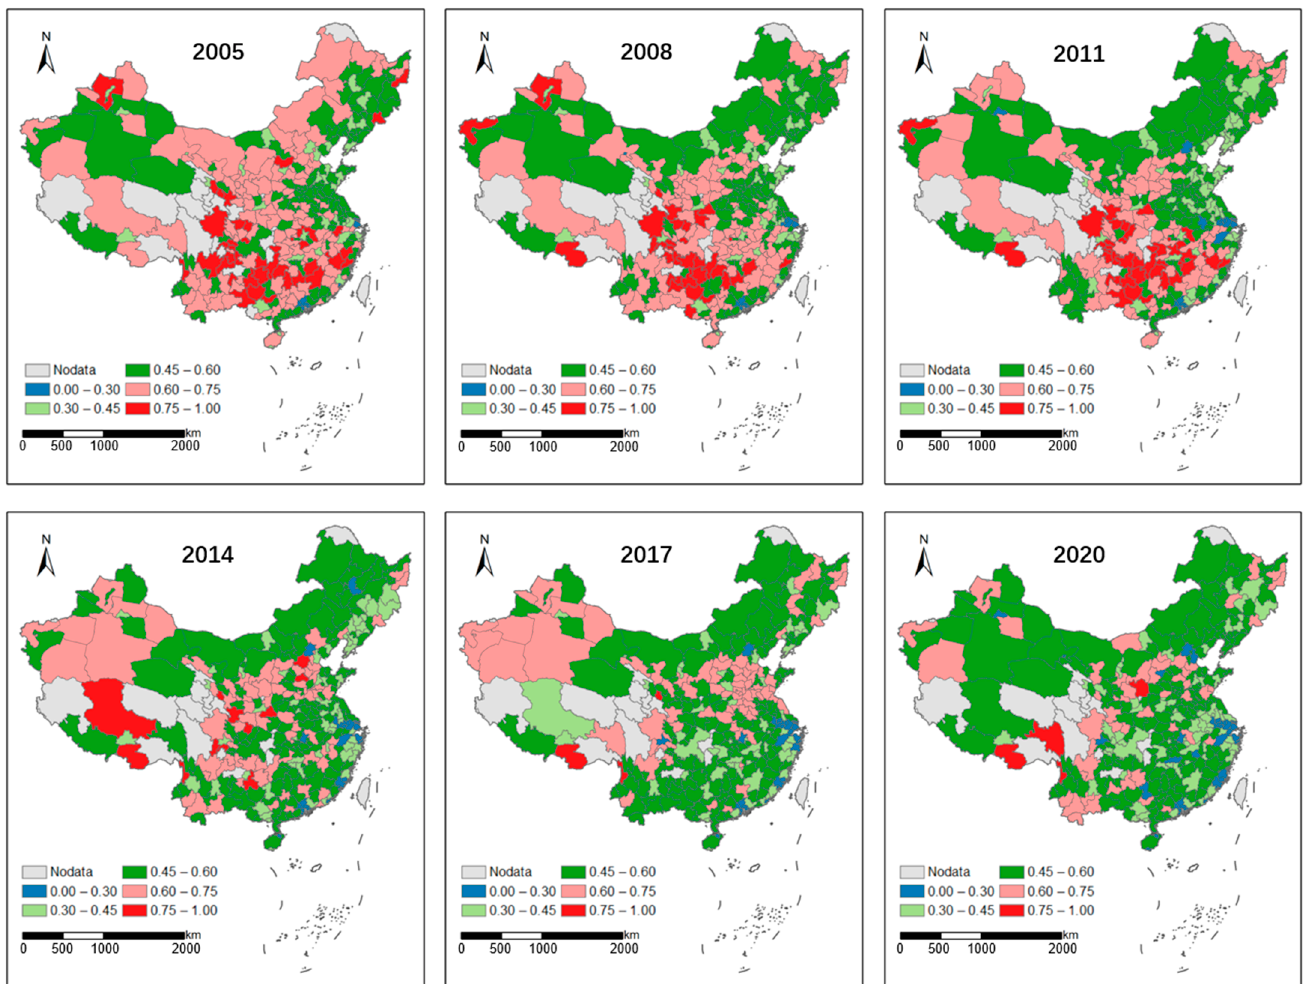
Figure 1. Spatial distribution of urban sprawl index of Chinese cities from 2005 to 2020.